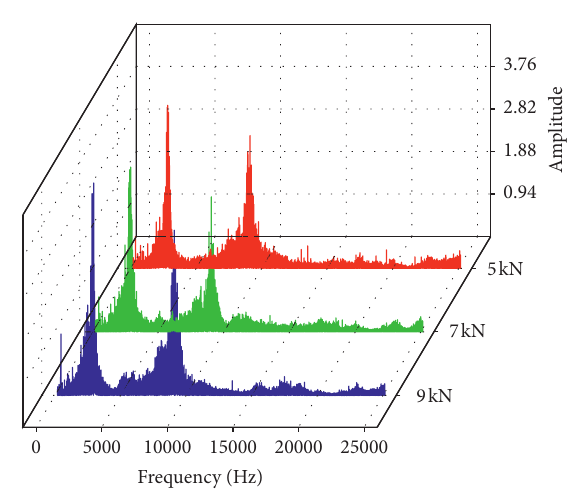
Figure 5: Frequency distribution of the vibration signal of outer ring fault under the same speed and different